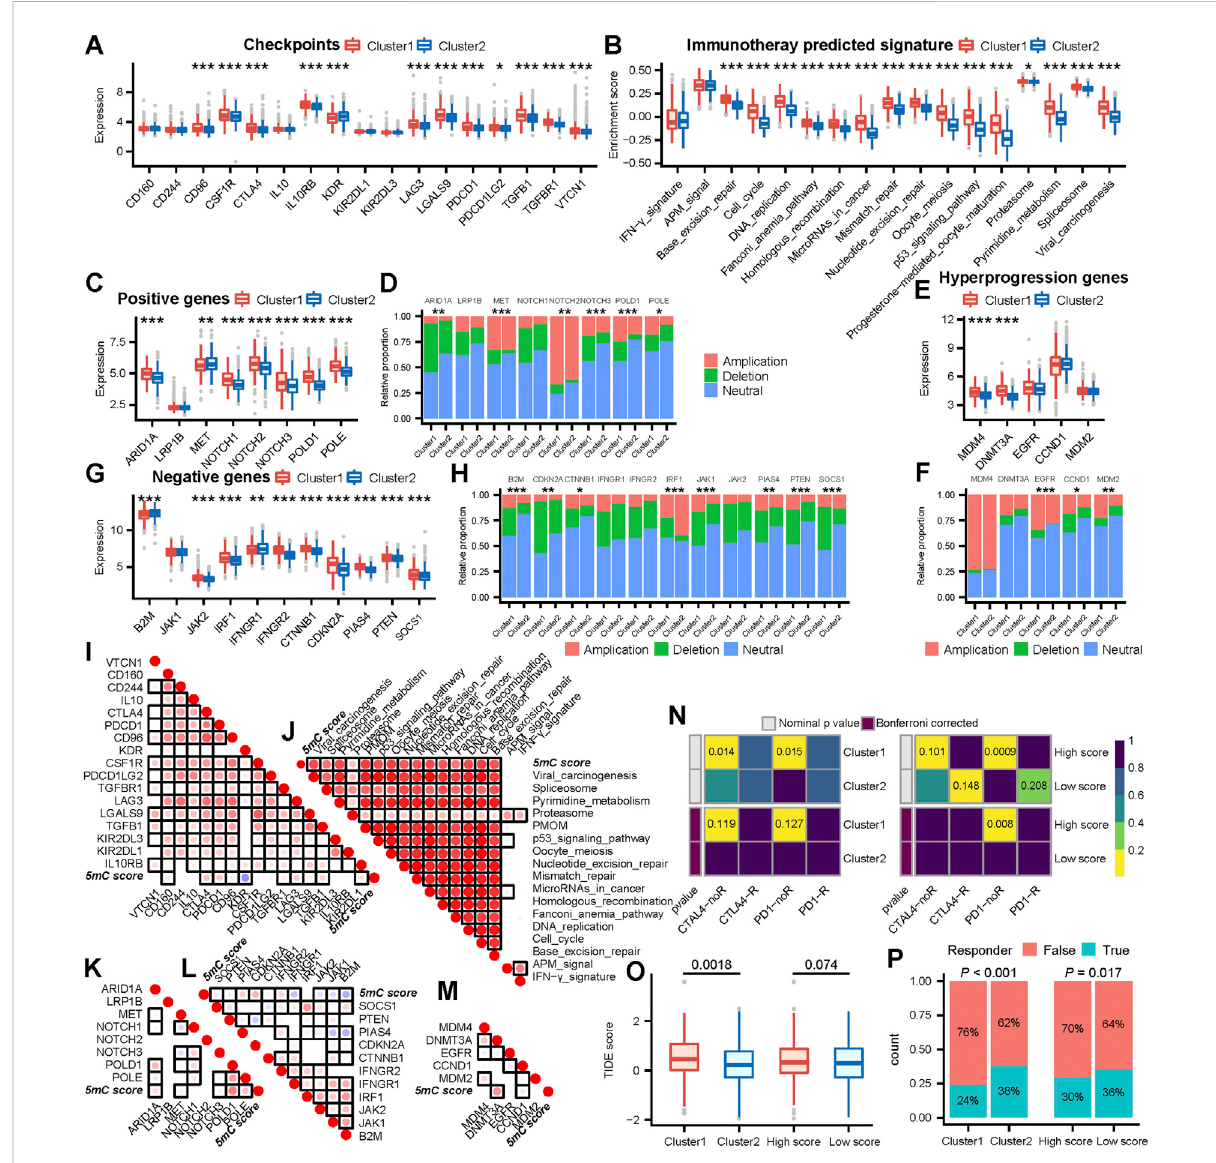
FIGURE 4 5mC cluster 1 and a high 5 mC score were correlated with a worse ICB response in the meta cohort. (A) Differences in the level of immune checkpoint expression between 5 mC clusters. (B) Differences in the enrichment scores of positive ICB response-related signatures between 5 mC clusters. (C) Differences in the level of positive ICB response-related gene signature expression between 5 mC clusters. (D) Differences in copy number alterations of positive ICB response-related gene signatures between 5 mC clusters. (E) Differences in the level of ICB hyperprogression-related gene signature expression between 5 mC clusters. (F) Differences in copy number alterations of ICB hyperprogression- related gene signatures between 5 mC clusters. (G) Differences in the level of negative ICB response-related gene signature expression between 5 mC clusters. (H) Differences in copy number alteration of negative ICB response-related gene signatures between 5 mC clusters. (I) Correlation between the level of immune checkpoint expression and 5 mC scores. (J) Correlation between the enrichment scores of positive ICB response- related signatures and 5 mC scores. (K) Correlation between the level of positive ICB response-related gene signature expression and 5 mC scores. (L) Correlation betweenthelevel ofnegative ICBresponse-related genesignature expressionand5 mCscores. (M) Correlation between thelevel of ICB hyperprogression-related gene signature expression and 5 mC scores. For (I)-(M), each point represents the correlation between 5 mC scores and the expression of each gene. The points are color-coded by correlation. The red color indicates a positive correlation, whereas the blue color represents a negative correlation. The light color represents a low correlation and progressively darker colors represent a higher correlation. The black box represents a signi fi cant correlation ( p < 0.05). (N) The subclass mapping analysis showed a signi fi cant difference in response to anti-PD- 1 therapy among 5 mC clusters and score groups. Each cell is color-coded by p value according to the color legend. (O) The TIDE analysis indicated that patients in cluster 1 had a worse response to ICB treatment ( p < 0.05). (P) The TIDE analysis predicted that patients in cluster 1 and patients with higher scores had a signi fi cantly lower proportion of responders to ICB treatment. * p < 0.05, ** p < 0.01, *** p < 0.001, PMOM Progesterone −